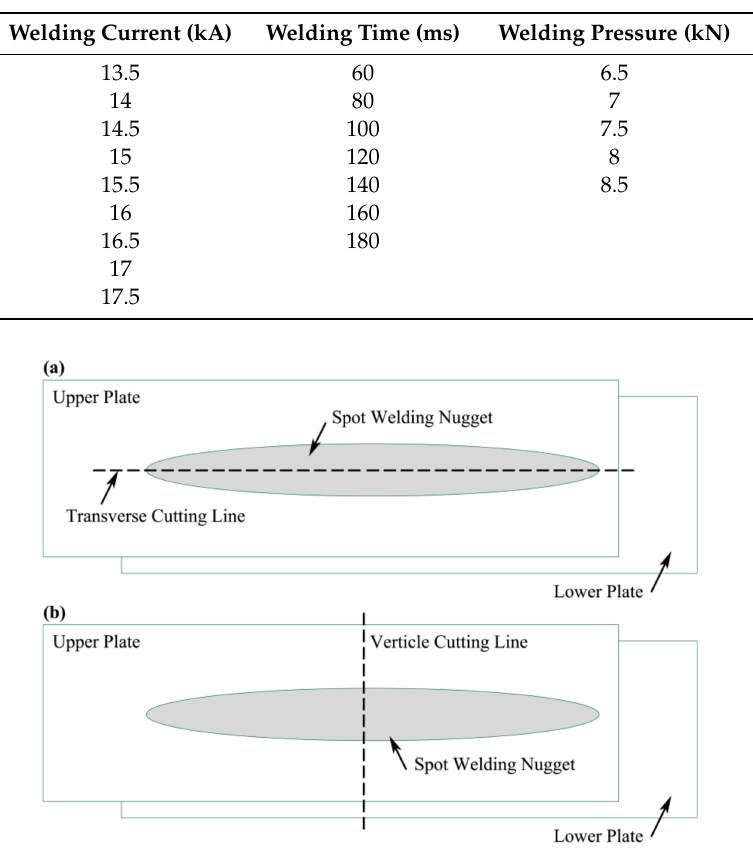
Table 4. Adopted parameter sets for the rectangular terminal electrode.